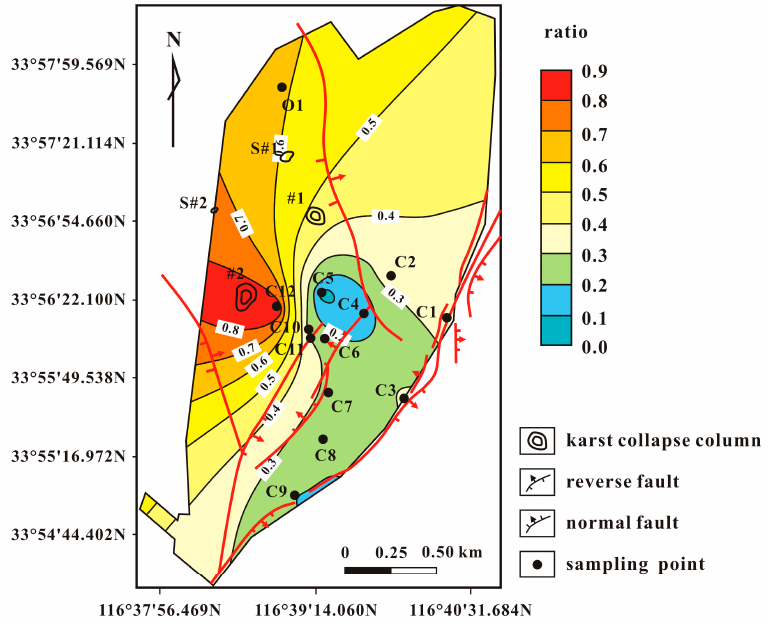
Figure 8. Contour map of groundwater mixing ratio in the study